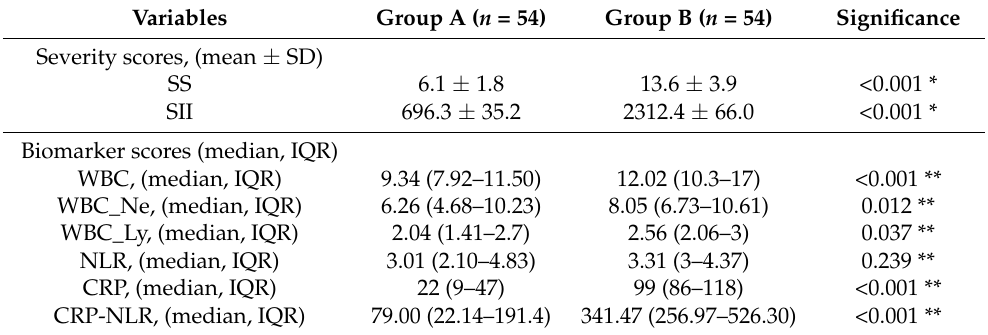
Table 5. Comparison of severity scores and biomarker scores among patients with odontogenic